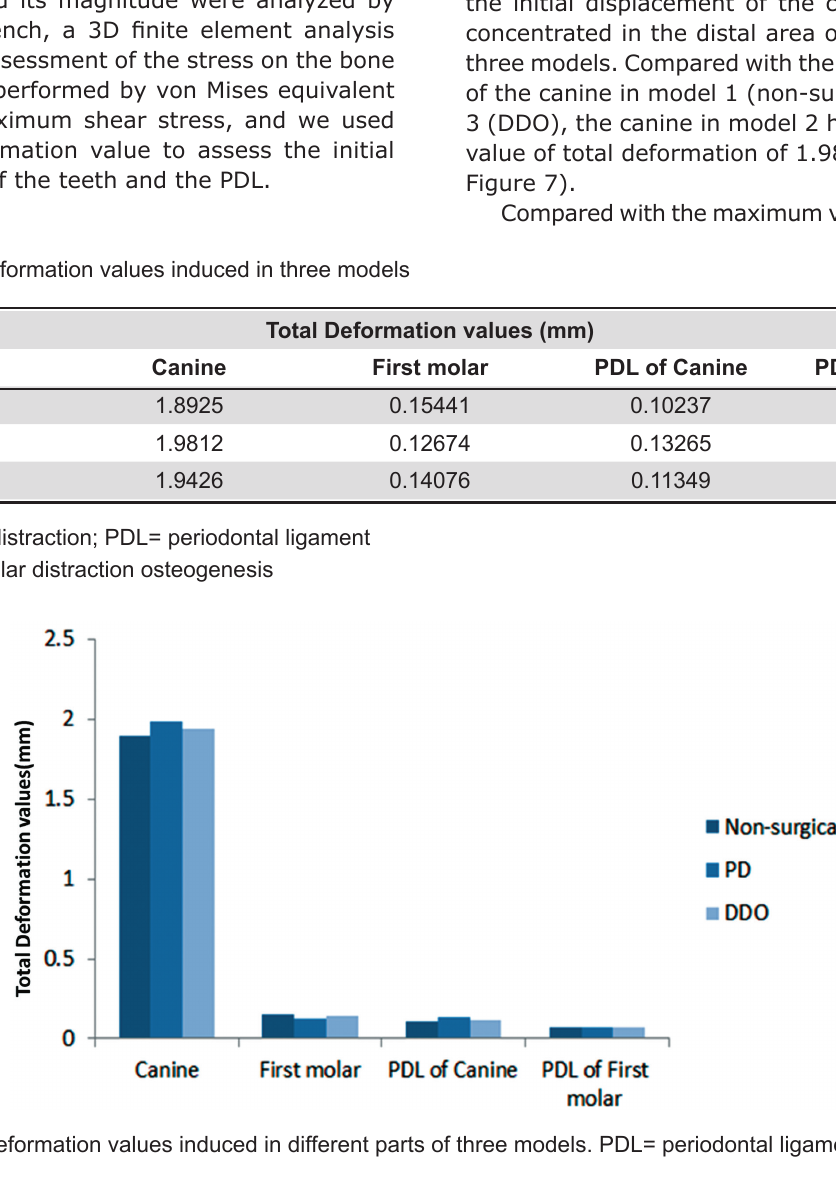
Figure 7- Total deformation values induced in different parts of three models. PDL= periodontal ligament Table 2- Equivalent (von Mises) Stress values induced in three